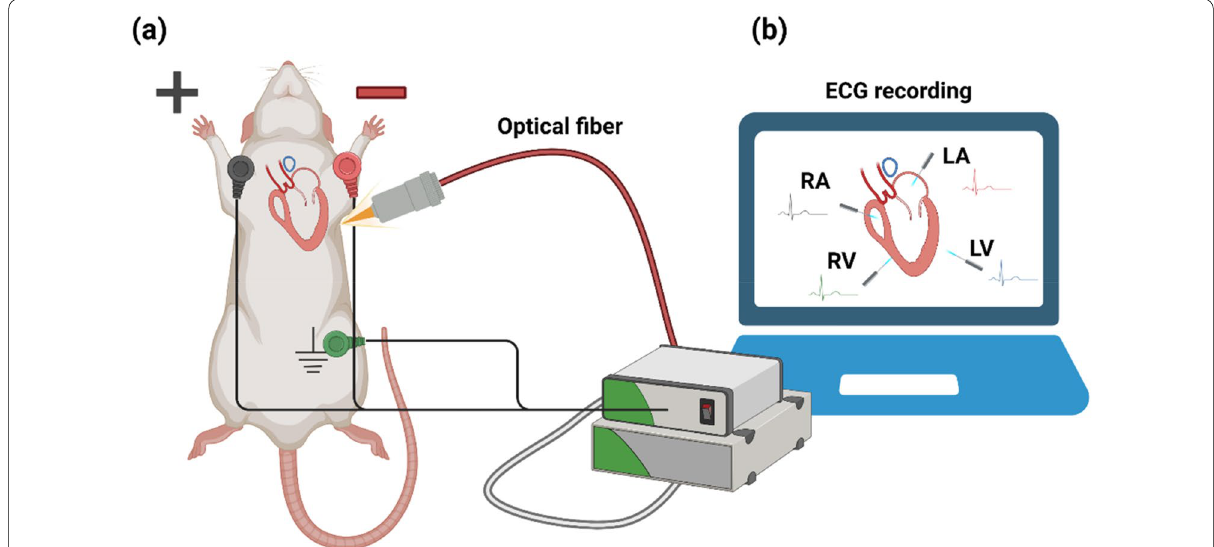
Fig. 1 Non‑invasive investigation of cardiac electrophysiology with continuous ECG recording. a Representation of the setup system and epicardial photostimulation in mice. b ECG tracing of heart excitation originated by epicardial light stimulation of different regions of the